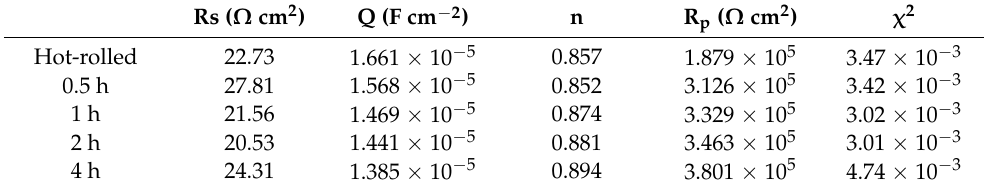
Table 3. Equivalent circuit parameters of TA10